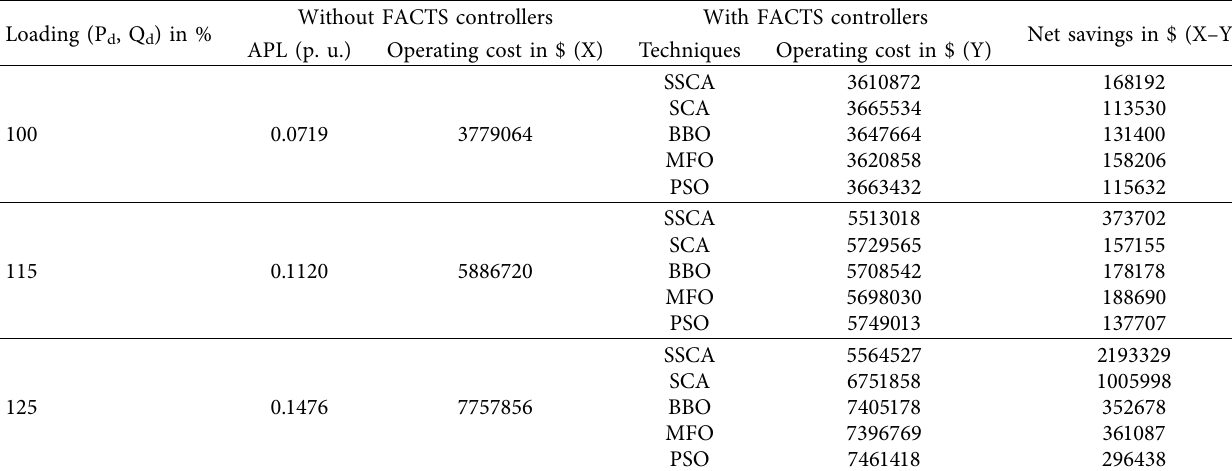
Table 4: Cost analysis without and with FACTS controllers for IEEE 30 bus system (best values are presented in bold).